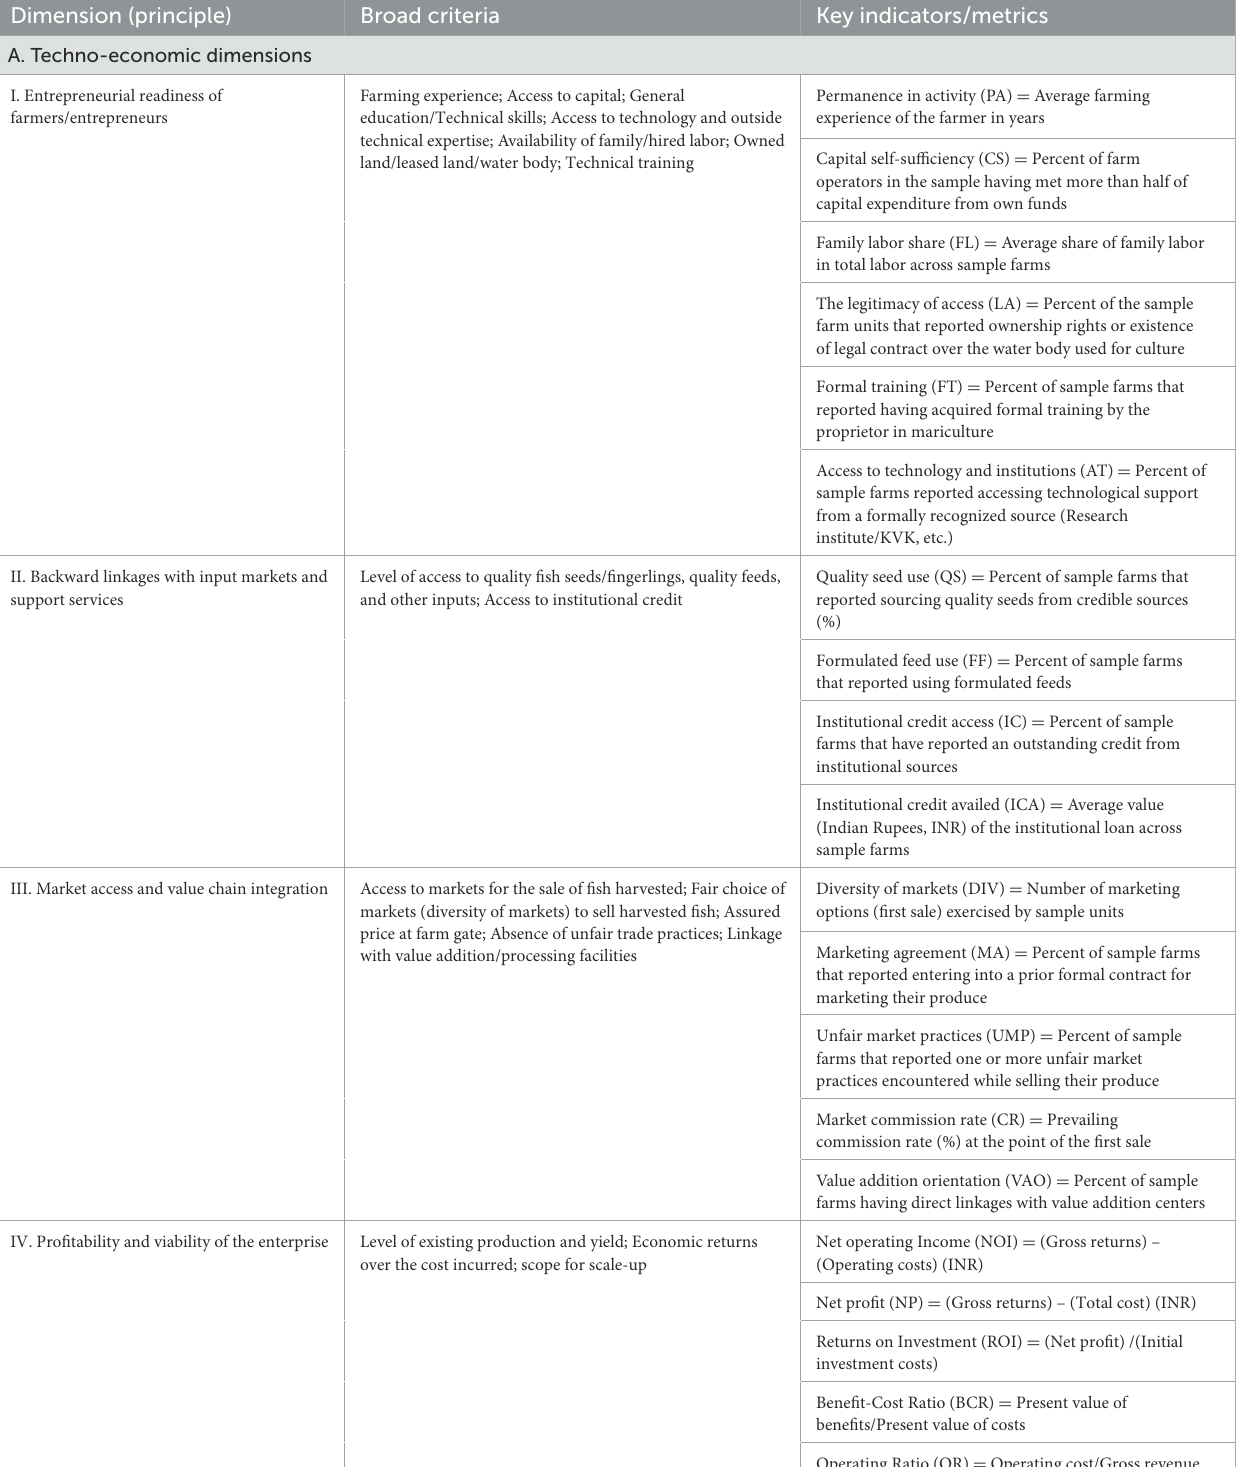
TABLE 1 Summary of key dimensions, criteria, and indicators as per PCI approach to assess the level of sustainability associated with selected mariculture enterprises in sample locations in India, 2022. Dimension